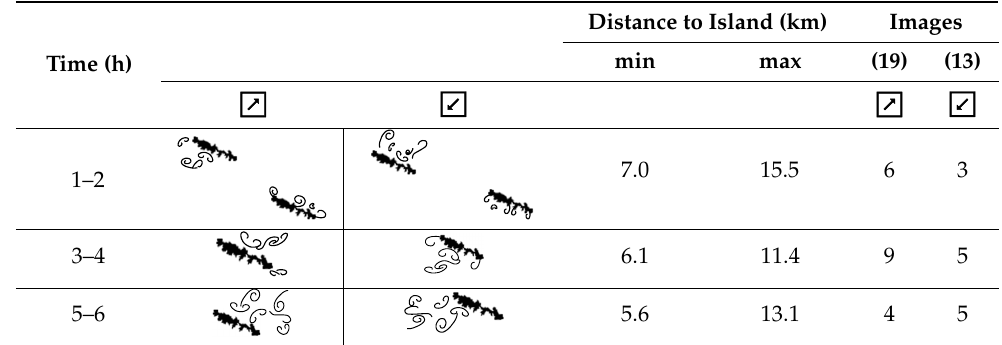
southwestern region of the PIMCPA, Viana Is. (Figure 1). Due to the interaction of the tidal current with the island, a wake is generated and formed behind it (leeward). Nearby, to the northeast, is another small island, 0.6 km long and 0.2 km wide, Cevallos Is., where eddies are also observable, but of a smaller size. This wake is observed as two vortices in the lee of the island rotating in opposite directions, and generally similar in size. The distance between the centers of the eddies is about 1 km, although it reaches up to 4.5 km (with southwards tide current fl owing past always forming downstream (in the lee) of Viana Is. (Table 3, Figure 5). When the tidal current began to turn shortly before image acquisition (t < 2 h), it can be observed how the wake starts to form in the same direction of the tidal current (Figure 5B, and sometimes eddies are observed breaking apart in the opposite direction, product of the previous tide (Figure 5A,C). The distance between the eddies increases as the time increases since their generation (Table 3). No e ff ect of i nor seasonality was observed on the structures.